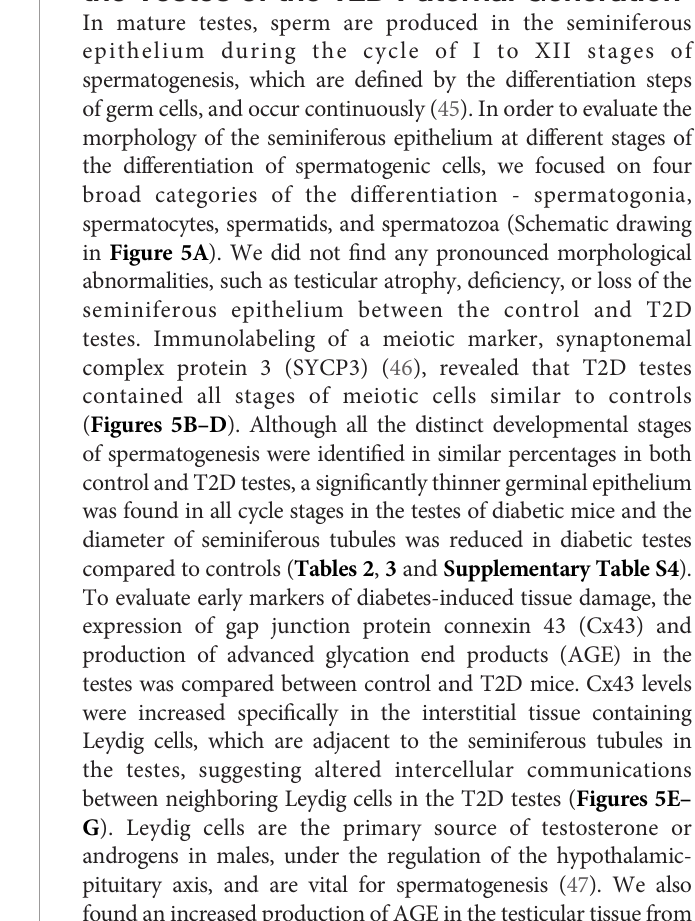
FIGURE 4 | Changes in sperm parameters of the paternal T2D generation. (A) Evaluations of caudal epididymal sperm from T2D and control males: abnormalities in the sperm head morphology and protamine 1 and protamine 2 ratios. (B) Evaluation of the expression of TERA and GAPDS. (C) Representative images of immunolabeling of TERA in the sperm acrosome and GAPDS mainly localized in the principal piece of the fl agellum of caudal epidymal sperm from T2D and control males (600x magni fi cation). Data are presented as the mean ± SEM. Differences between groups were tested by t -test (GraphPad Prism 7.0). *P < 0.05, ***P < 0.001, ****P < 0.0001. TERA, transitional endoplasmatic reticulum ATPase; GAPDS, glyceraldehyde 3- phosphate dehydrogenase-S.